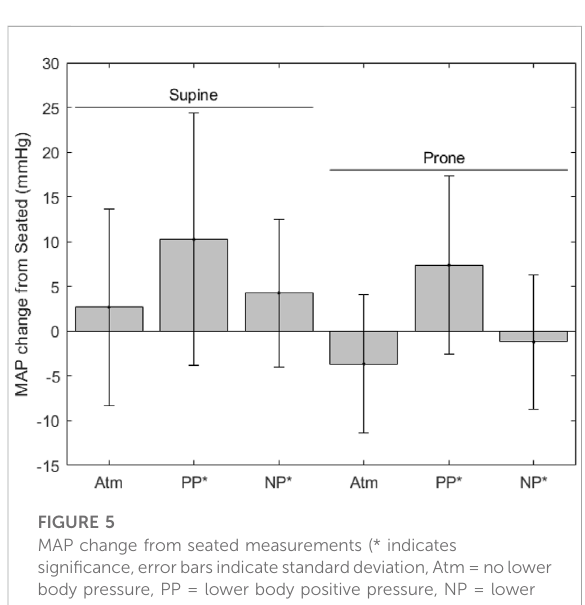
FIGURE 5 MAP change from seated measurements (* indicates signi fi cance,errorbarsindicatestandarddeviation,Atm=nolower body pressure, PP = lower body positive pressure, NP = lower body negative